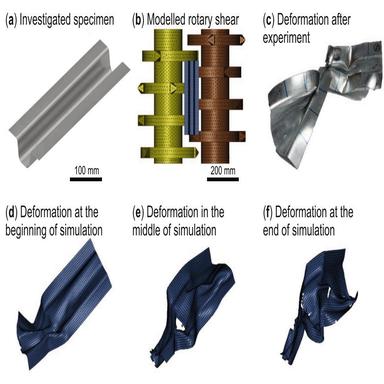
First results of ongoing simulation study: (a) feed particle: base profile of sample type A in initial state (steel, HCT500X), (b) meshed rotary shear and sample in initial state, (c) progeny particle from experimental shredding in rotary shear, (d) progeny particle at the beginning of Finite Element Method (FEM) simulation (rotary shear not depicted), (e) progeny particle in the middle of FEM simulation, (f) progeny particle at the end of FEM simulation.